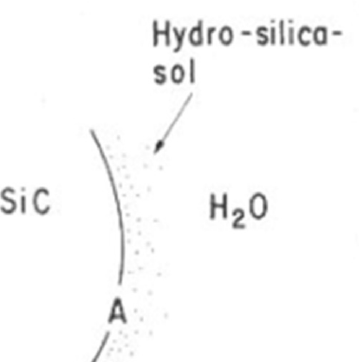
Figure 27. Dissolution model, assuming that a hydro–silica–sol is produced. Reprinted with permission from Reference [93]. Copyright 1989 The American Ceramic Society/Wiley.